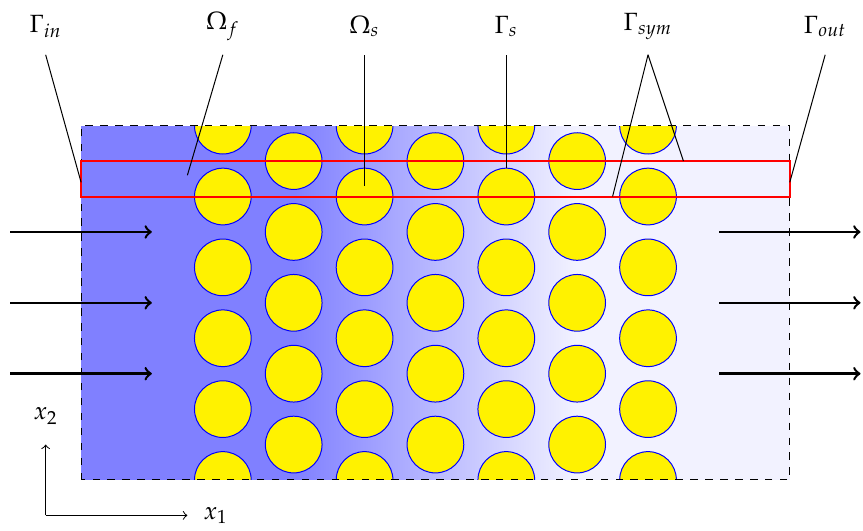
Figure 1. Sketch of the pore scale